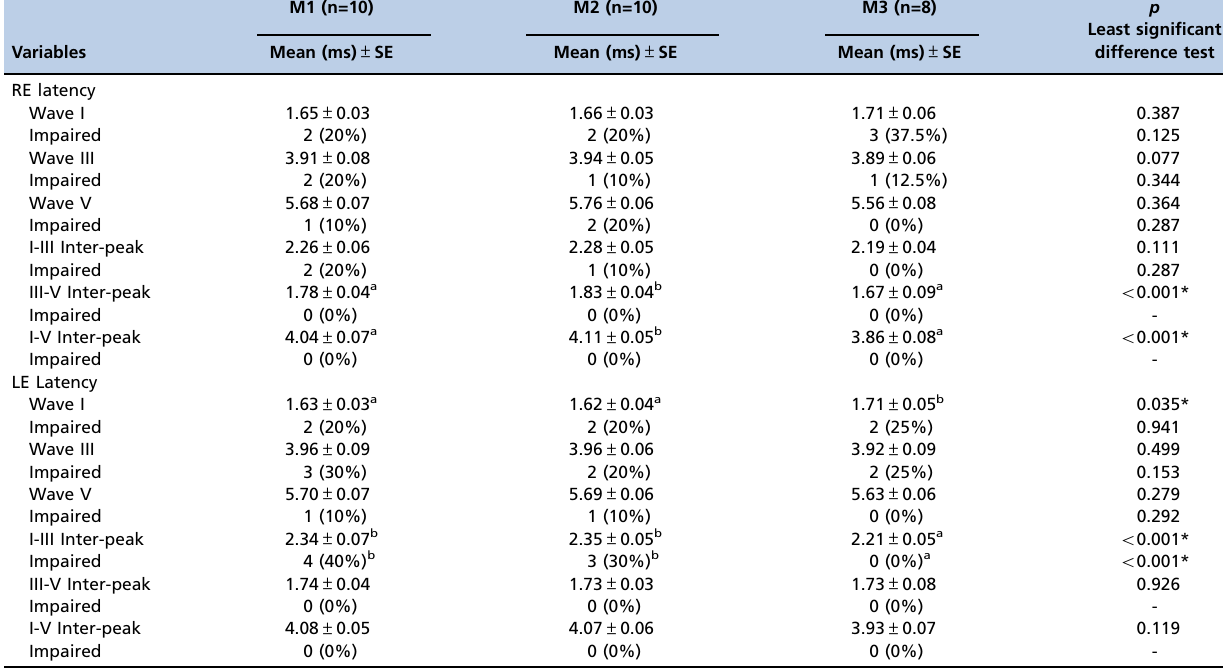
Table 4 - Descriptive absolute latency (ms) and inter-peak (ms) values in ABR at M1, M2, and M3.